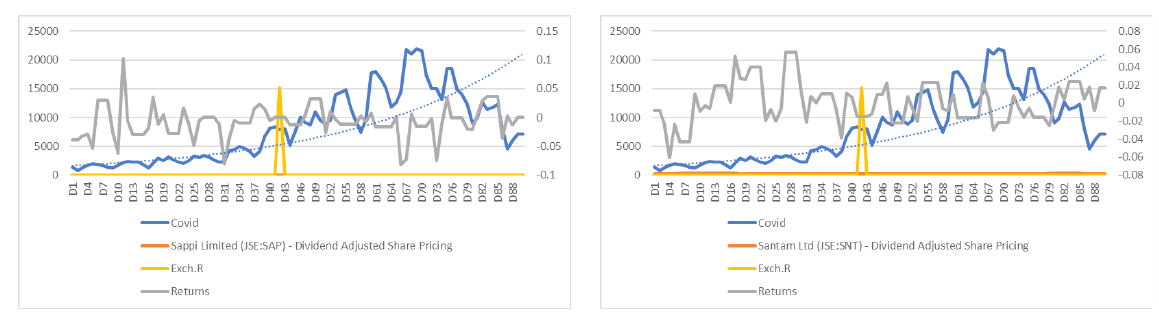
Figure 13. Santam Limited Figure 14. Sappi Limited